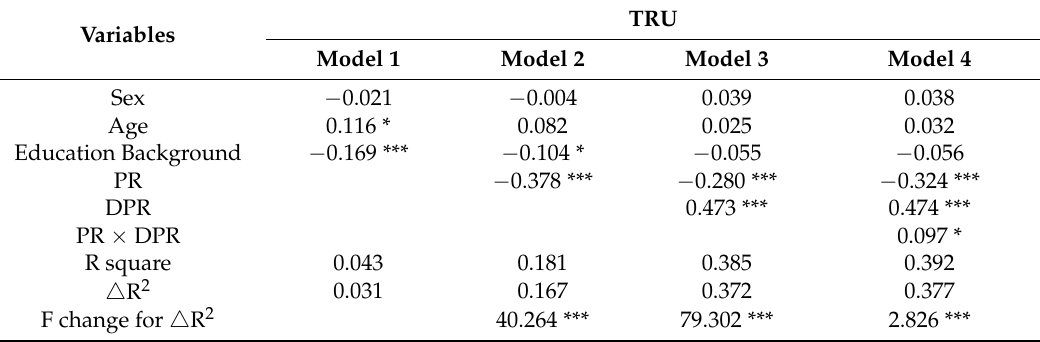
Table 6. Results of the regression